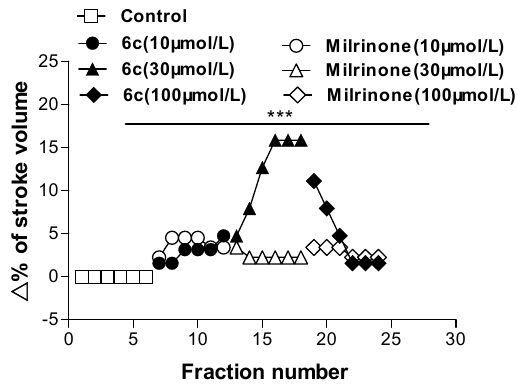
Figure 3. Concentration-response curves of compounds 6c and milrinone on stroke volume in beating rabbit atria (1.5 Hz). Values are means ± SE. *** p < 0.001 versus control.